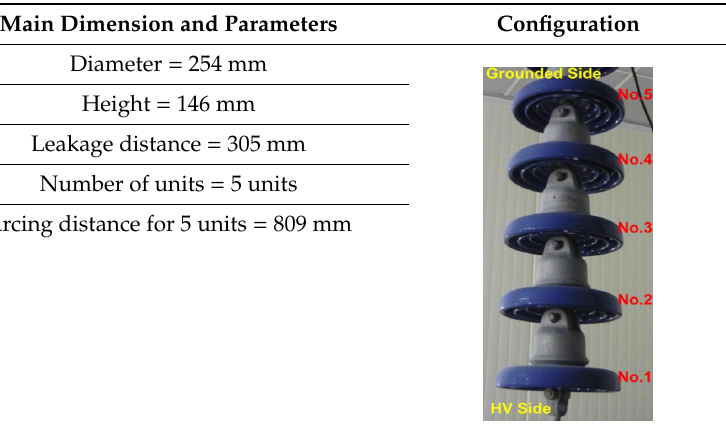
Figure 1. Artificial cold-climate room.